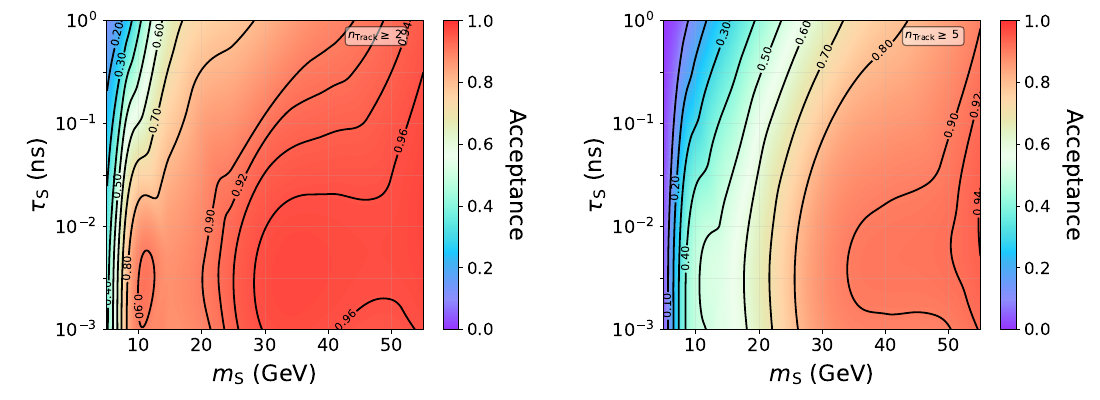
Figure 7. Acceptances for the Higgs portal scenario requiring at least two tracks (left) and least five tracks (right) passing the requirements listed in table